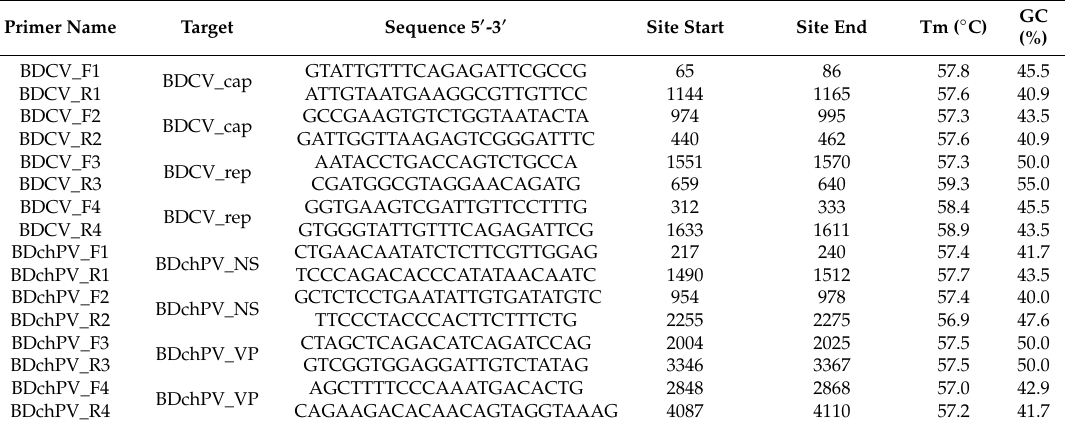
Table 1. PCR primers used in this